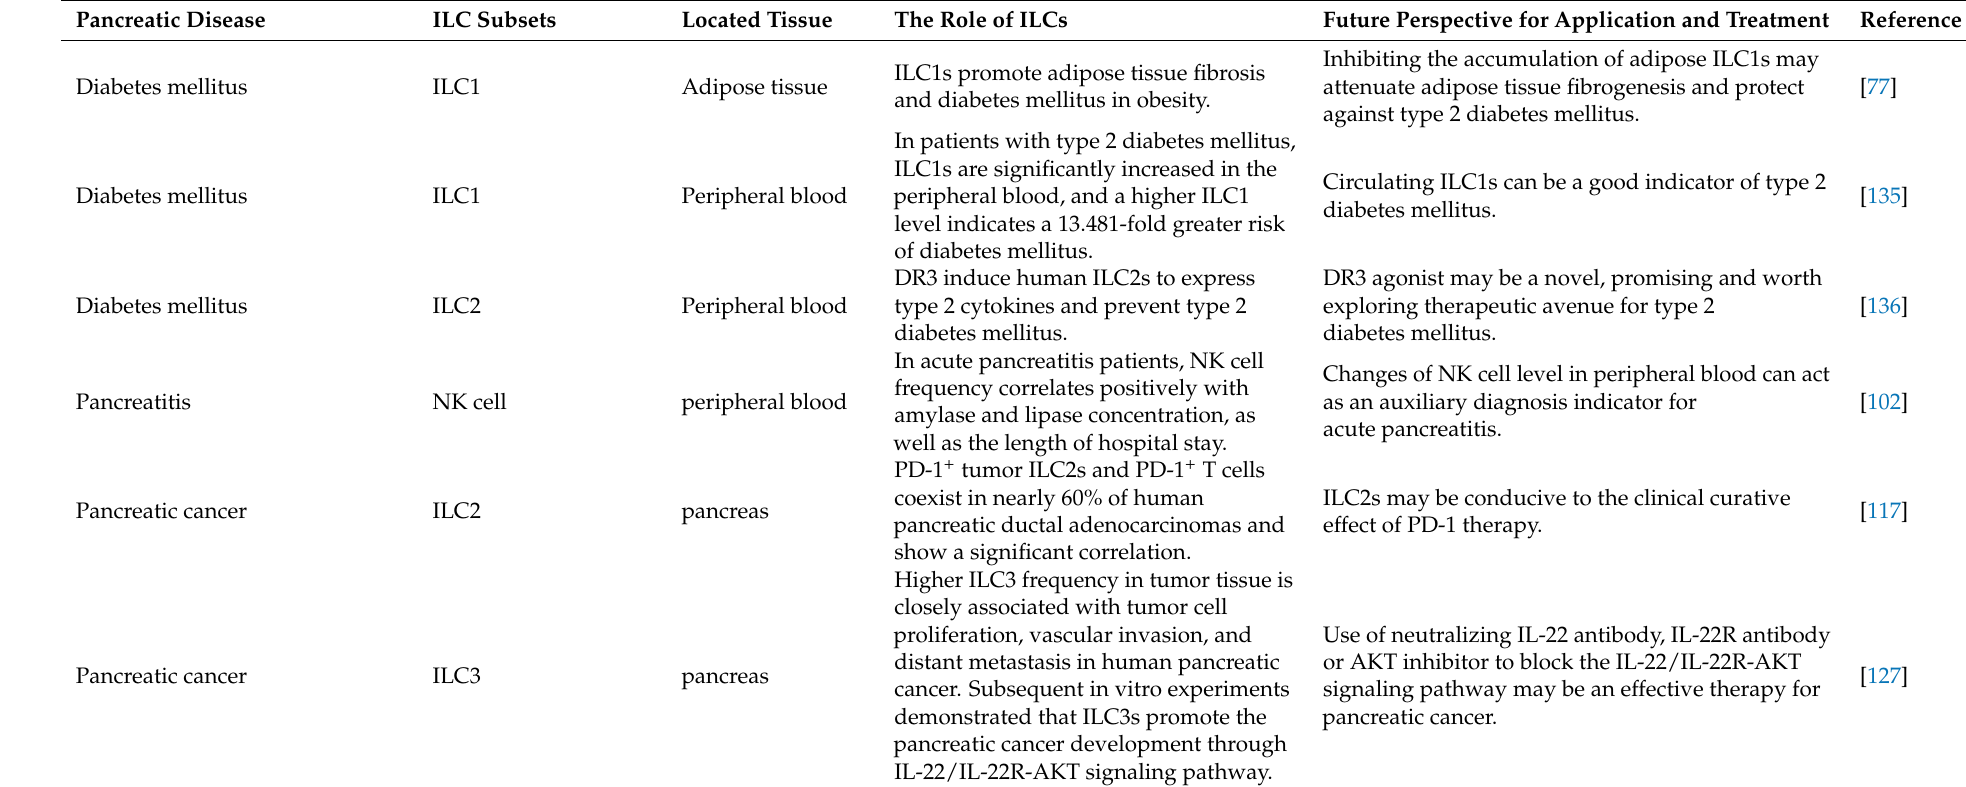
Table 2. Human clinical studies identifying ILC subsets associated with pancreatic disease and their possible